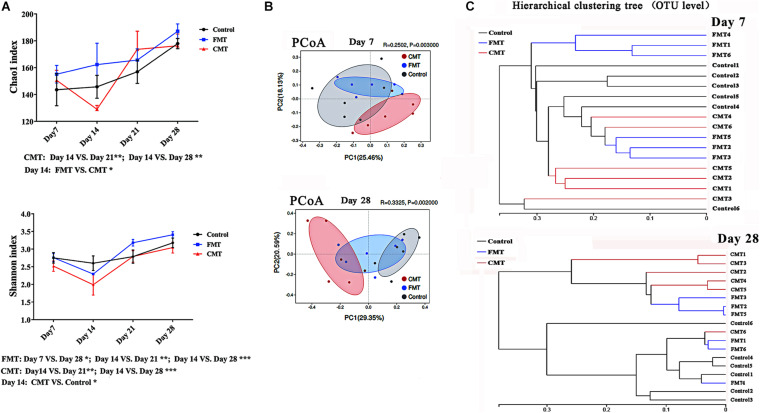
Diversity changes of intestinal microbiota in different piglets. (A) Changes in alpha diversity indexes (Chao and Shannon indexes, at the OTU level) of the gut microbiota in piglets after transplantation. * Indicates P < 0.05, ** indicates P < 0.01, and *** indicates P < 0.001; (B) Principle coordinate analysis (PCoA) plot based on the OTUs in different piglets on day 7 and day 28. (C) Hierarchical clustering analysis of the OTUs in different piglets on day 7 and day 28.